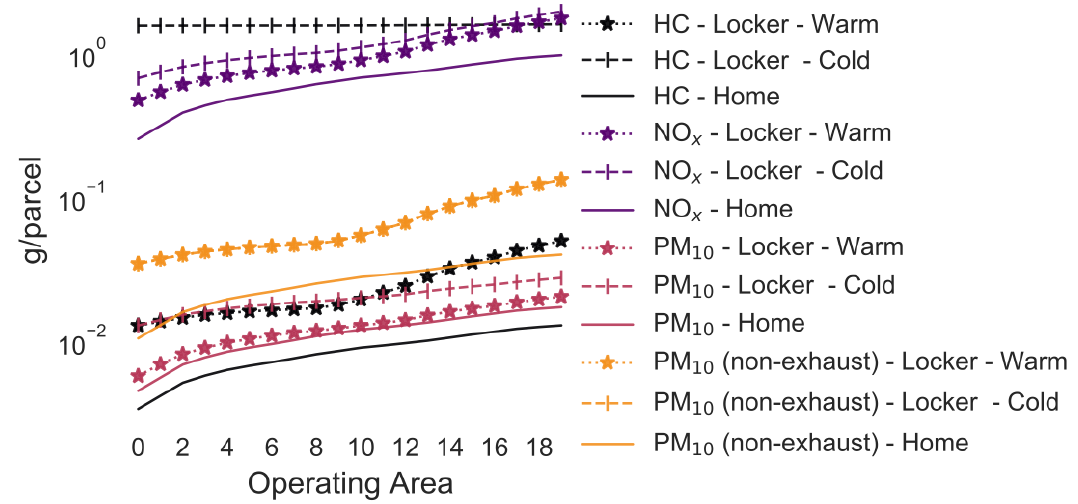
Figure 4. Selected pollutants for home delivery and delivery to lockers (logarithmic scale).